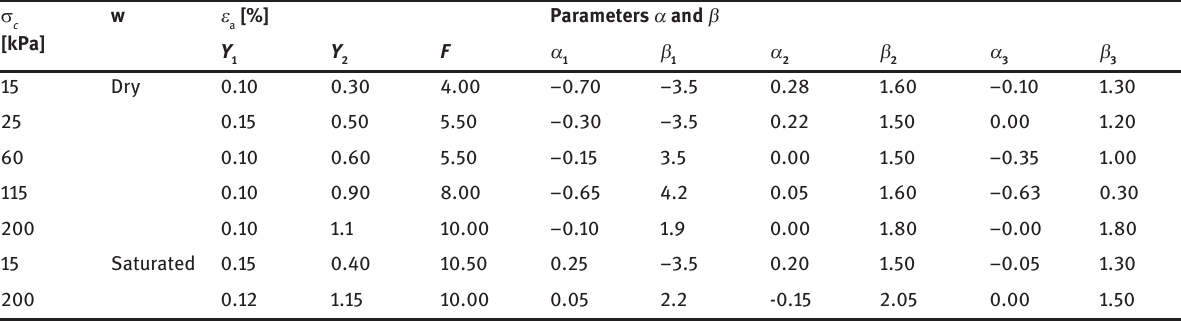
Table 3: Characteristic points and stress–dilatancy parameters for scaled railway ballast.